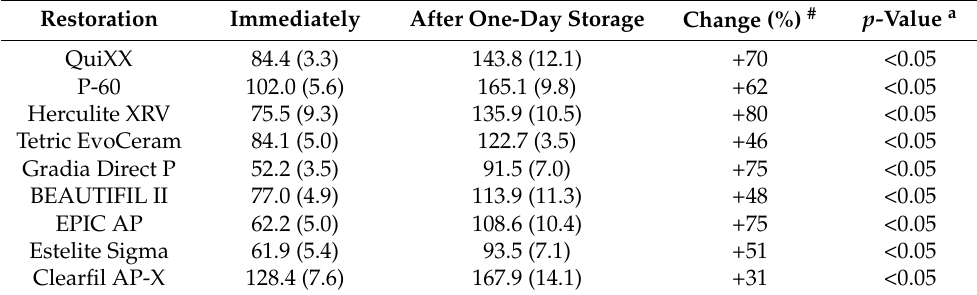
Table 5. Flexural strength of restorative materials (MPa, mean (S.D.)).